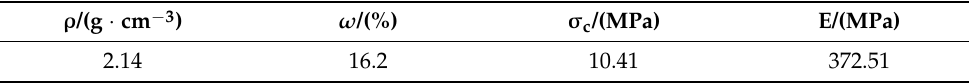
Table 1. Physical and mechanical parameters of natural red-bedded soft rock.